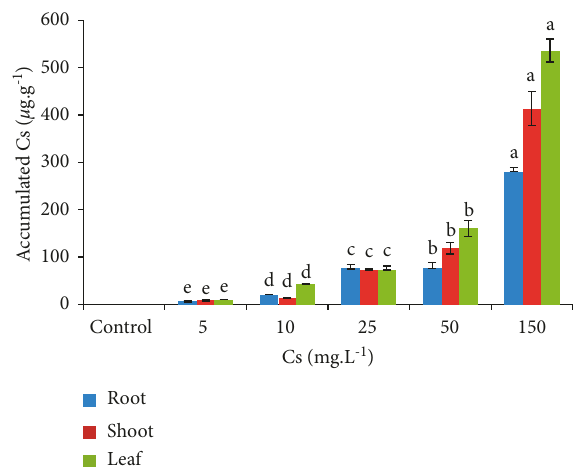
Figure 6: Cesium accumulation in root, stem, and leaves of S. portulacastrum. All the values are mean of twelve readings ± S.E. One-way ANOVA significant at p ≤ 0.05. Different letters indicate significantly different values in root, stem, or leaves (DMRT p ≤